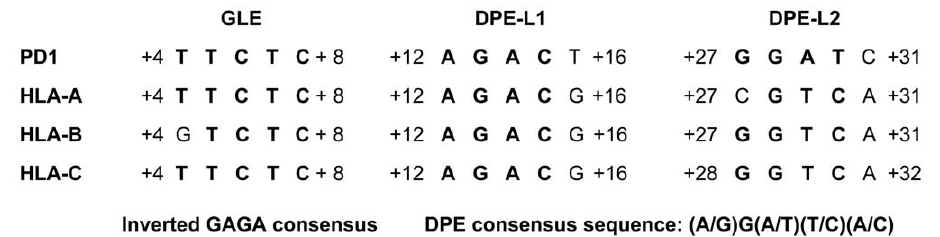
Figure 1. Three downstream sequences are conserved among MHC class I promoters. The sequences + 4 to + 8 and + 12 to + 16 and + 27/28 to + 31/32 of the swine SLA class I gene, PD1, and the human HLA class genes, HLA-A, HLA-B and HLA-C were aligned. All four have conserved GAGA factor binding site and DPE consensus sequences.